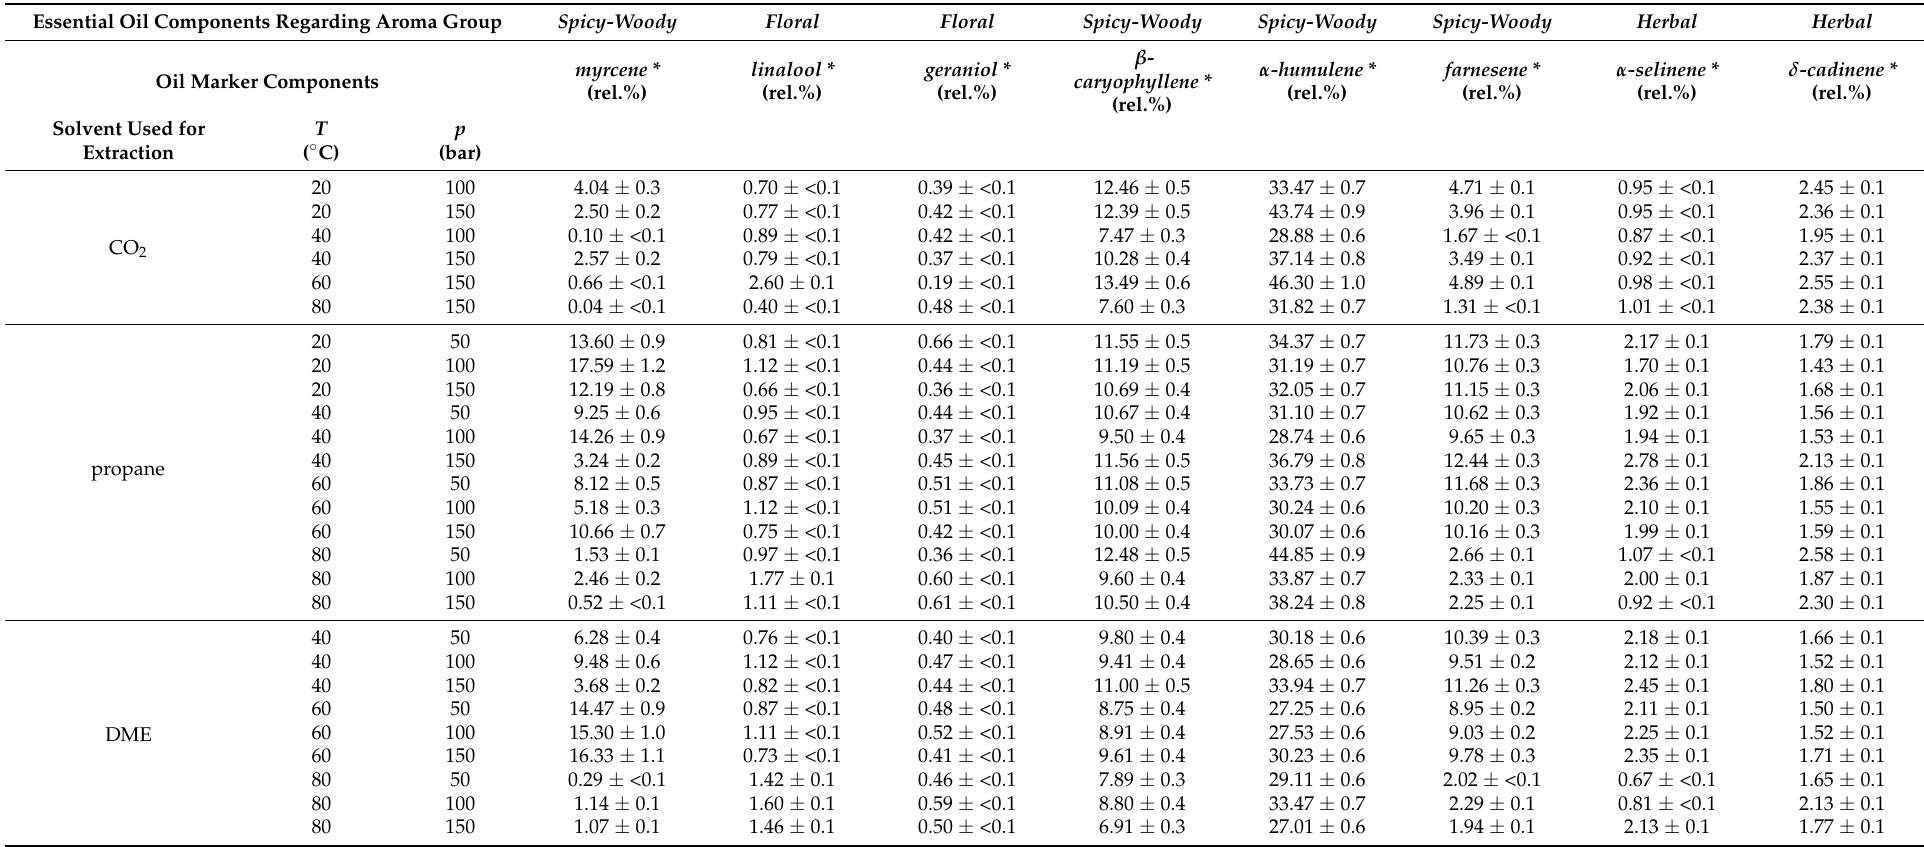
Table 3. Evaluation of hop oil marker components, connected with a distinct odour, present in the oil in extracts derived with different solvents in combination with different pressures and temperatures, expressed in relative